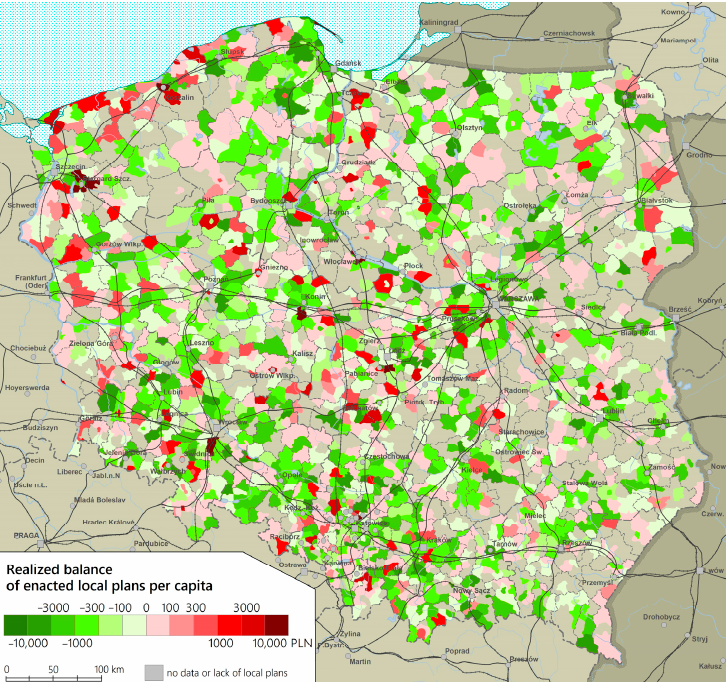
Figure 3. Forecast balance of revenues and expenditures per capita by communes, for the year 2019. Source: based on unpublished data of the Ministry of Development and Statistical Office of Poland.